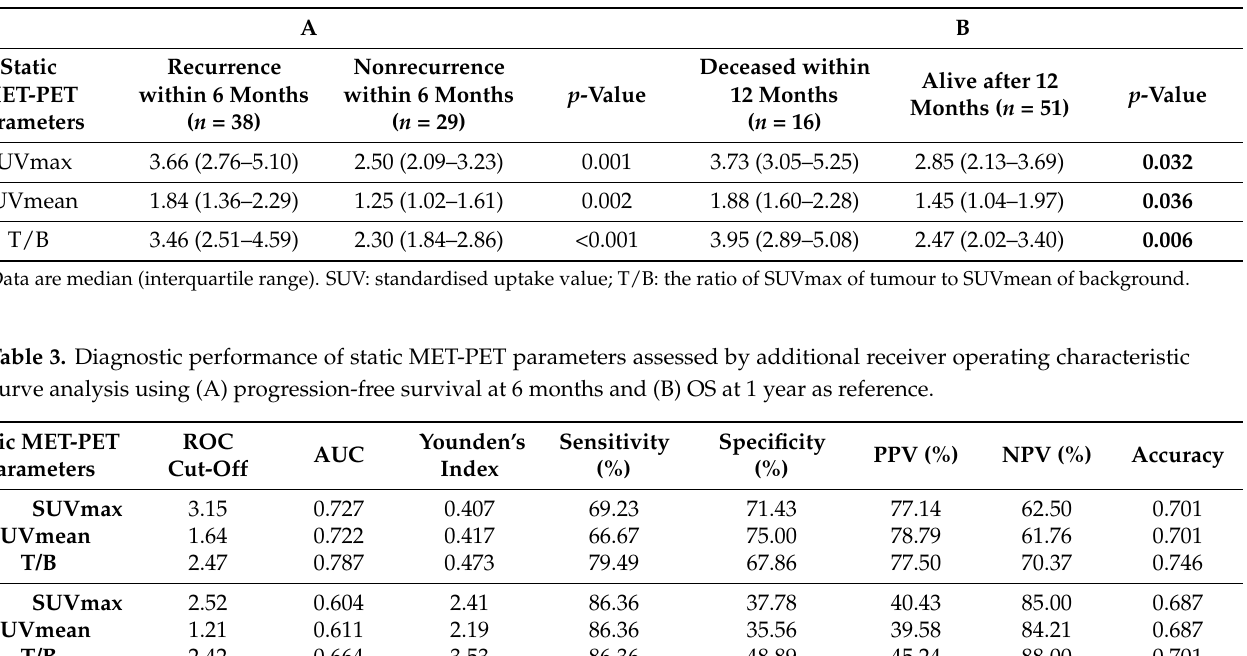
ROC: receiver operating characteristic; AUC: area under the curve; SUV: standardised uptake value; T/B: the ratio of SUVmax of tumour to SUVmean of background; PPV: positive predictive value; NPV: negative predictive value.